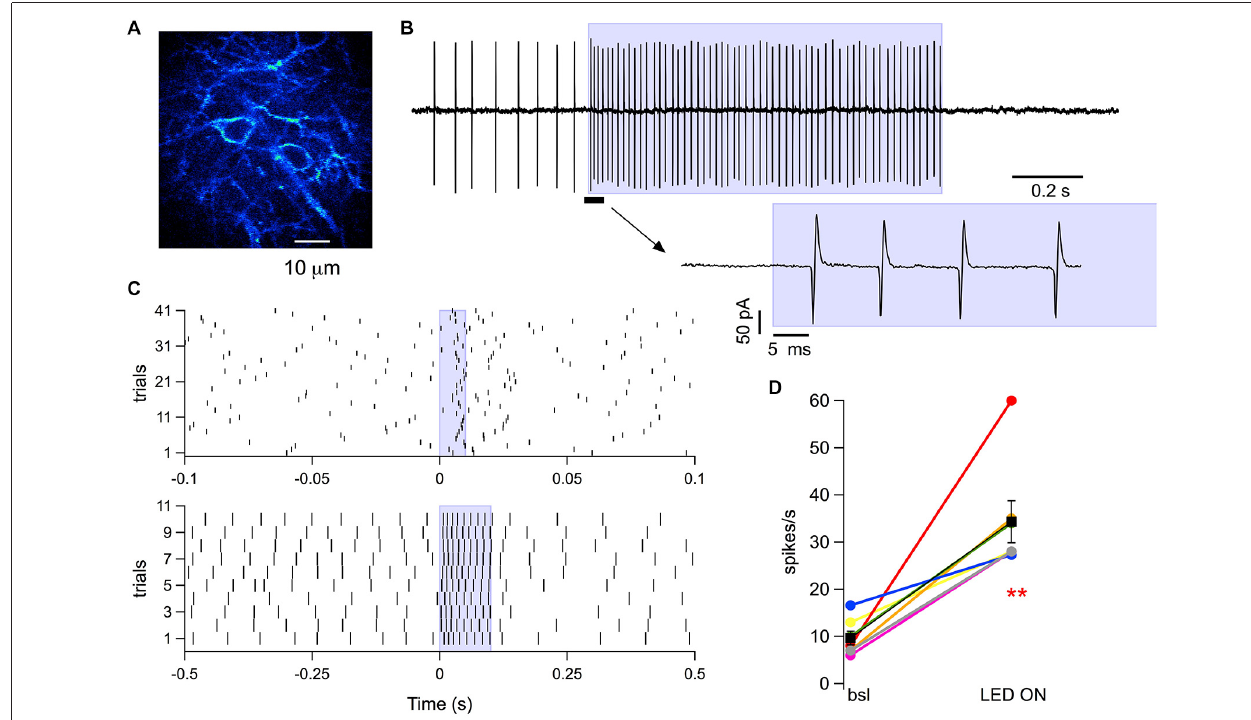
during the onset of the light pulse (as indicated by the solid black bar and the arrow). (C) Raster plots from the same MLI for spikes recorded in consecutive runs before, during and after photostimulation lasting either 10 ms (upper panel) or 100 ms (lower panel) at the time indicated by the blue boxes. (D) Pooled data for the spike frequency obtained in seven MLIs in control conditions and during 1 s photostimulation. Colored dots represent individual somata and black squares the corresponding average; error bars are SEM; p value for paired Student’s t -test: 0.003. ** p ≤ 0.01. The power out of the fiber for all recordings shown was 6